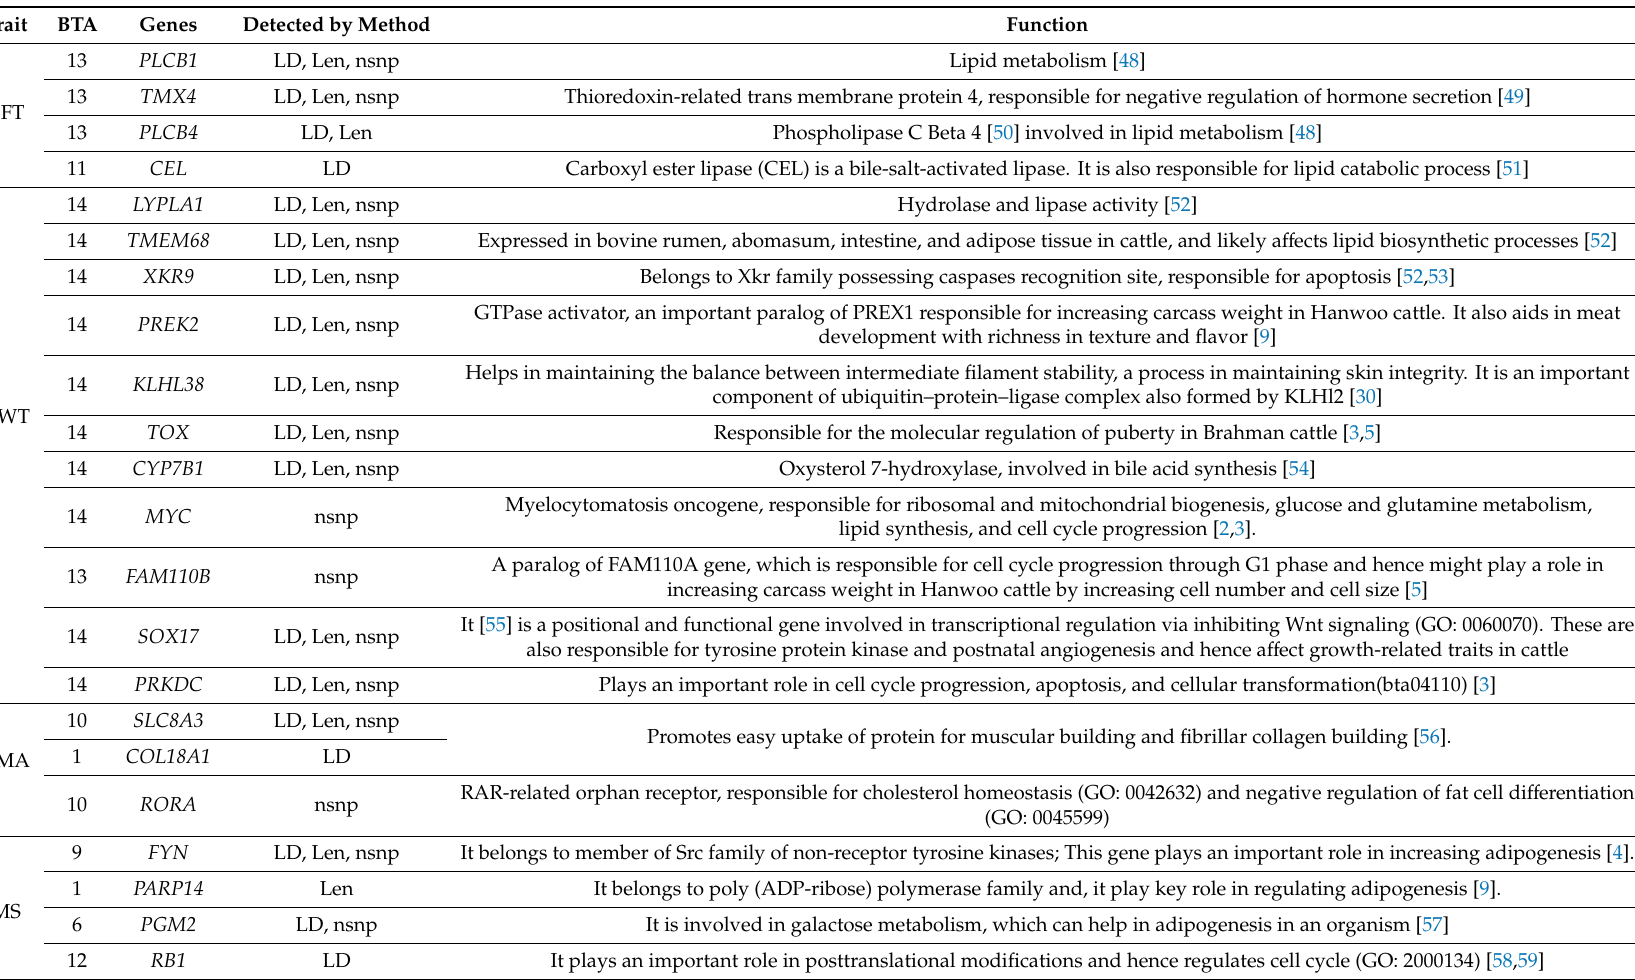
Table 2. List of genes related to carcass trait identified by di ff erent haplotype methods and their